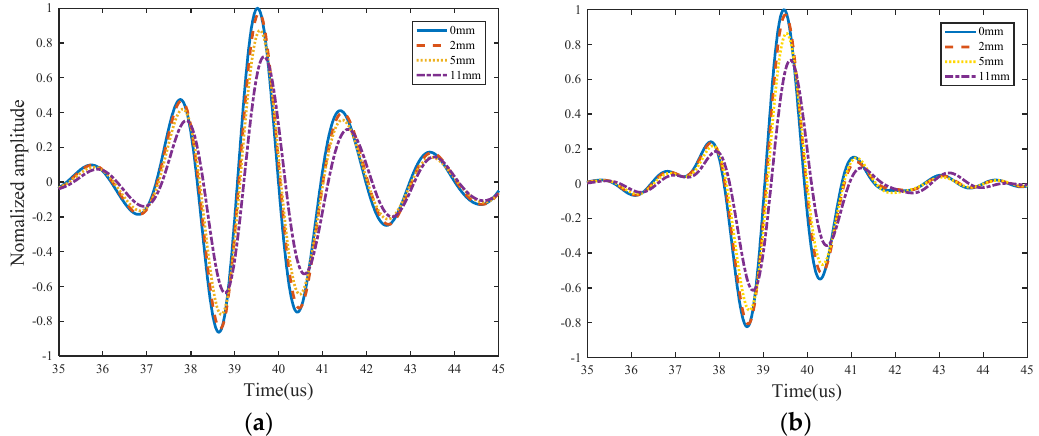
Figure 11. Some waveforms processed with dispersion compensation pulse compression of ( a ) 300~700 kHz L-Chirp signal and ( b ) 500 kHz GCC signal.